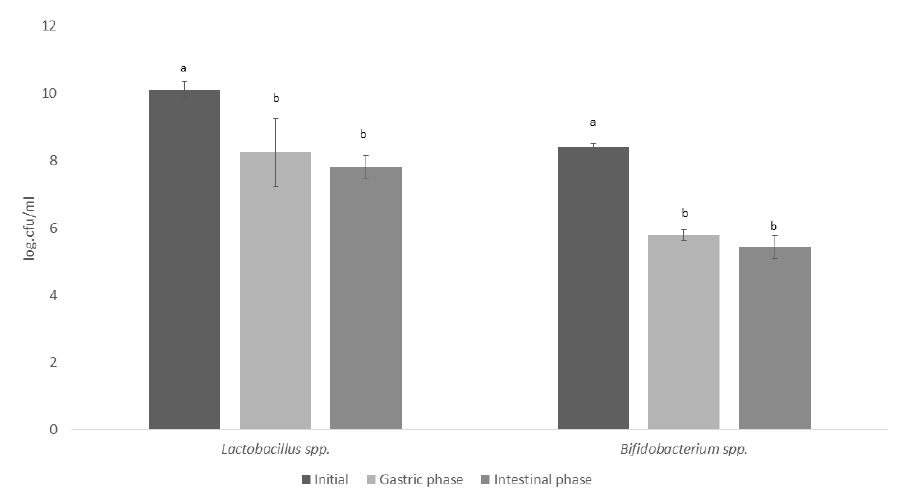
Figure 2. Survival of Lactobacillus helveticus R0052 and Bifidobacterium longum R0175 under simulated GI conditions in Simulator of the Human Intestinal Microbial Ecosystem (SHIME ® ). a,b, different superscript lowercase letters represent differences ( p < 0.05), based on Tukey’s test.